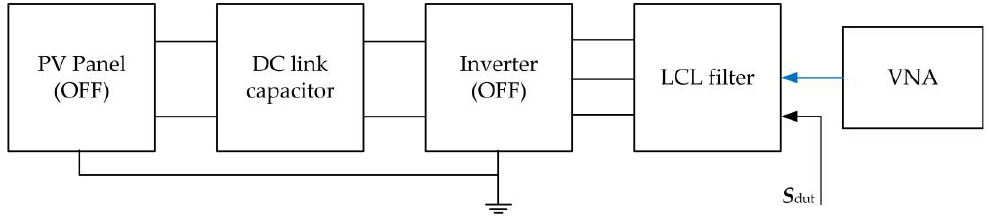
Figure 4. Measurement setup exploited to evaluate the entries of the admittance matrix (passive part of the black-box model).